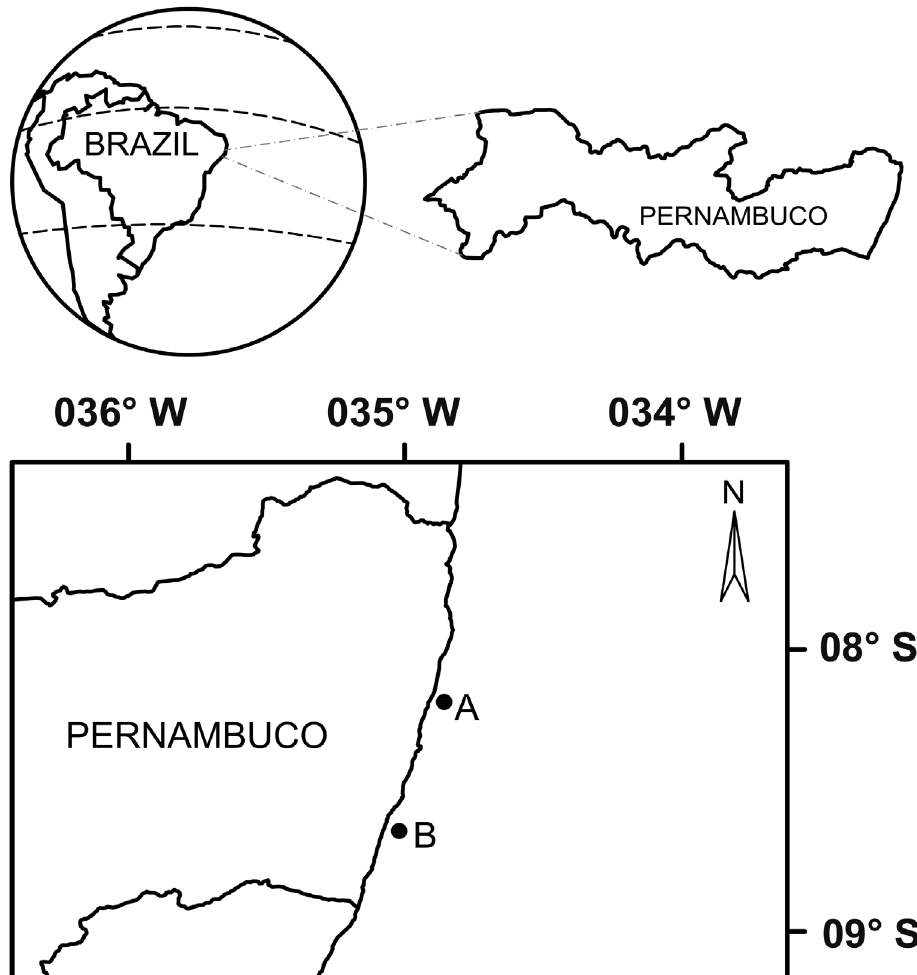
FIGURE 1 | Area of prawn-trawling fleet operation in: A) Jaboatão dos Guararapes; B) Barra de